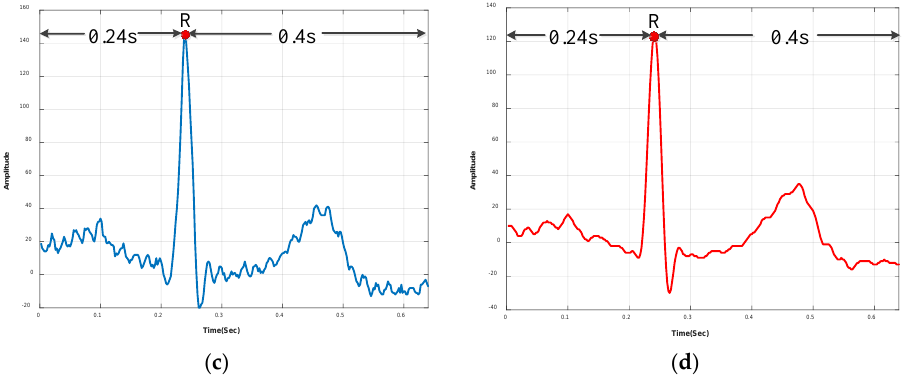
Figure 3. Segmented heartbeats with and without noise. ( a ) a noisy heartbeat from the MIT-BIH-AHA; ( b ) a denoised heartbeat from the MIT-BIH-AHA; ( c ) a noisy heartbeat from the ECG-ID; ( d ) a denoised heartbeat from the ECG-ID.